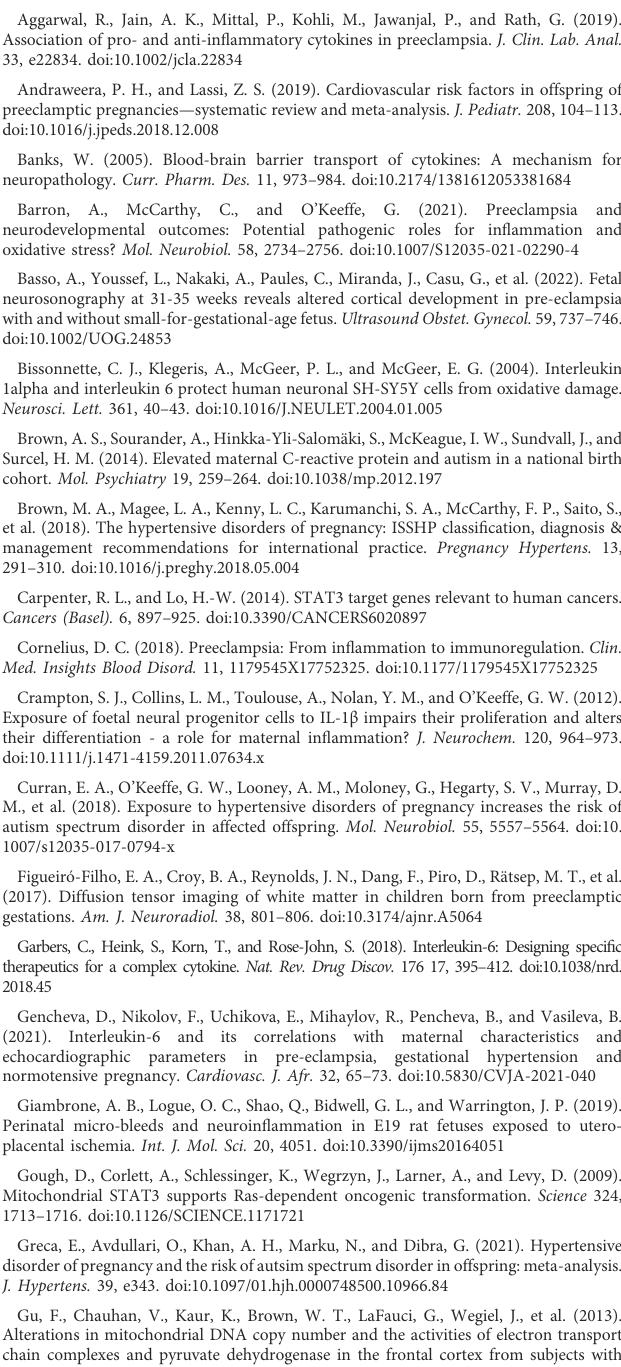
MitoSOX TM Red, (B) MitoGreen, or (C) MitoTracker TM Red FM, as measures of mitochondrial superoxide, biomass and membrane potential, respectively. Data are mean + SEM from four serum samples per group for A-C ( n = 4), expressed as percentage of the control. (Student ’ s unpaired t -test). SUPPLEMENTARY FIGURE S3 Comparison of ReNcell ® VM neural progenitor cells at day 1 vs. day 7 in vitro . ReNcell ® VM neural progenitor cells were differentiated for 7 days by removal of EGF and FGF2 from the culture medium. Blue = DAPI, green = β III tubulin, red = GFAP, PhC = phase contrast